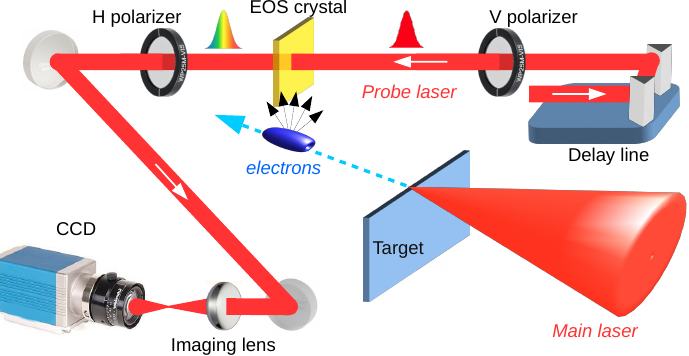
Figure 1. Setup of the experiment. The FLAME laser is focused onto a metallic target. The EOS diagnostics, based on a ZnTe crystal placed 1 mm downstream from the target, allows for measuring the temporal profile of the emitted electron bunch by means of an ancillary laser beam (probe), directly split from the main laser, probing the local birefringence induced by the electric field